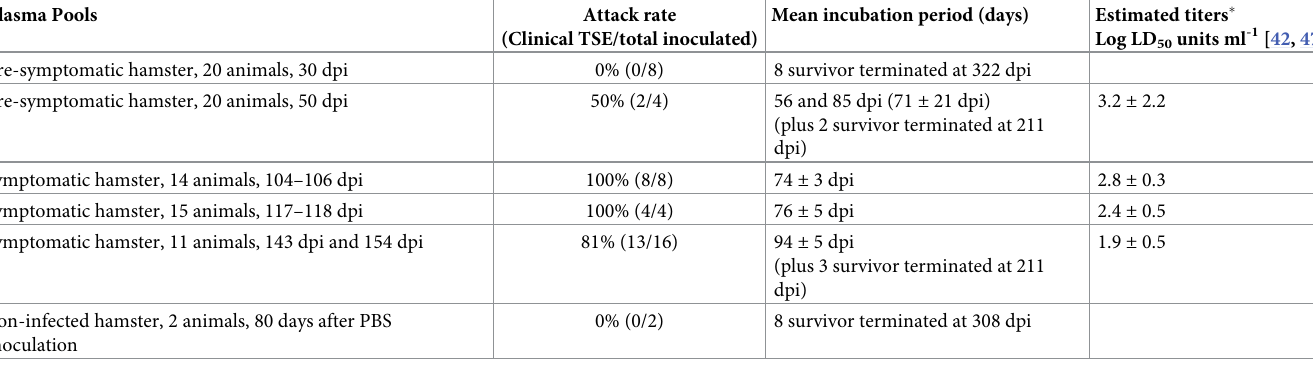
Table 3. Summary of bioassays with Tg (SHaPrP) mice that were inoculated with plasma coated PSR1 beads. Plasma